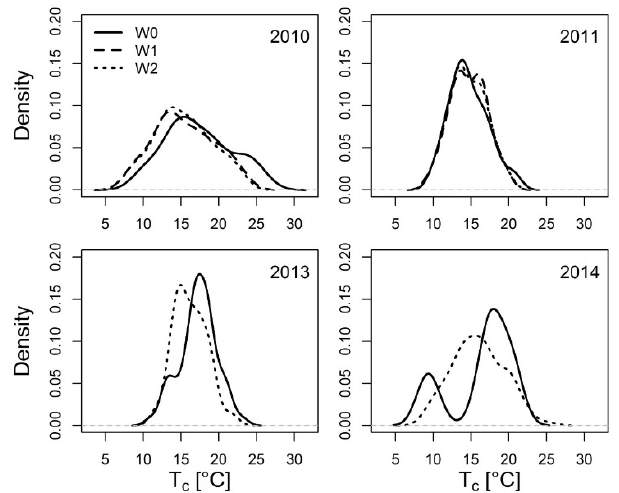
Figure 1. Density plot of available surface temperature observations (Tc, daily averages of hourly values) for the different observation years and irrigation treatments (W0 = no irrigation, W1 = medium deficit irrigation and W2 = full irrigation).